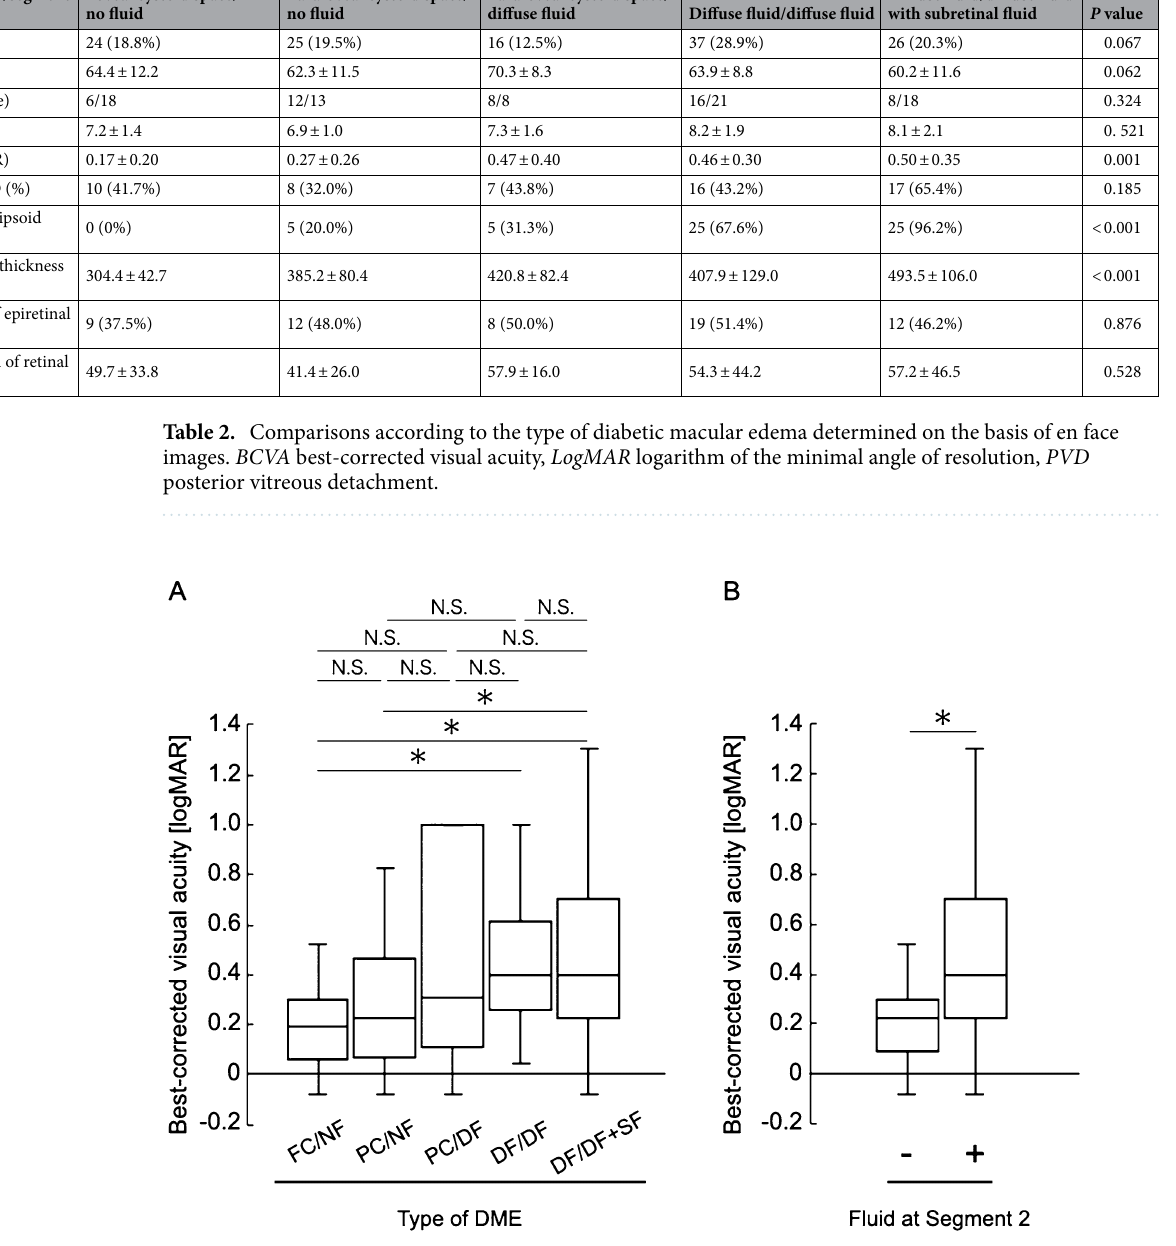
Figure 6. Relationship between visual acuity and the en face image-based classification of diabetic macular edema (DME). ( A ) Best-corrected visual acuity values are compared among the DME types. ( B ) Best-corrected visual acuity values are compared according to the presence or absence of fluid at Segment 2. DME diabetic macular edema, logMAR logarithm of the minimal angle of resolution, FC/NF foveal cystoid space/no fluid type, PC/NF parafoveal cystoid space/no fluid type, PC/DF parafoveal cystoid space/diffuse fluid type, DF/DF diffuse fluid/diffuse fluid type, DF/DF + SF diffuse fluid/diffuse fluid with subretinal fluid type, N.S. not significant; * P <